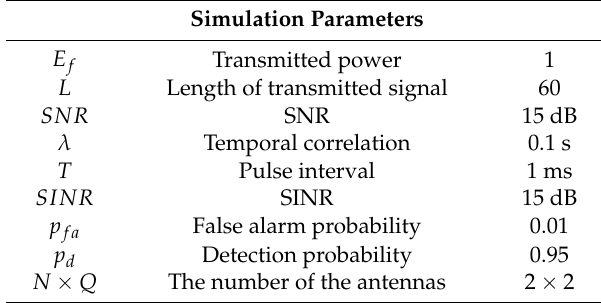
Table 1. Simulation